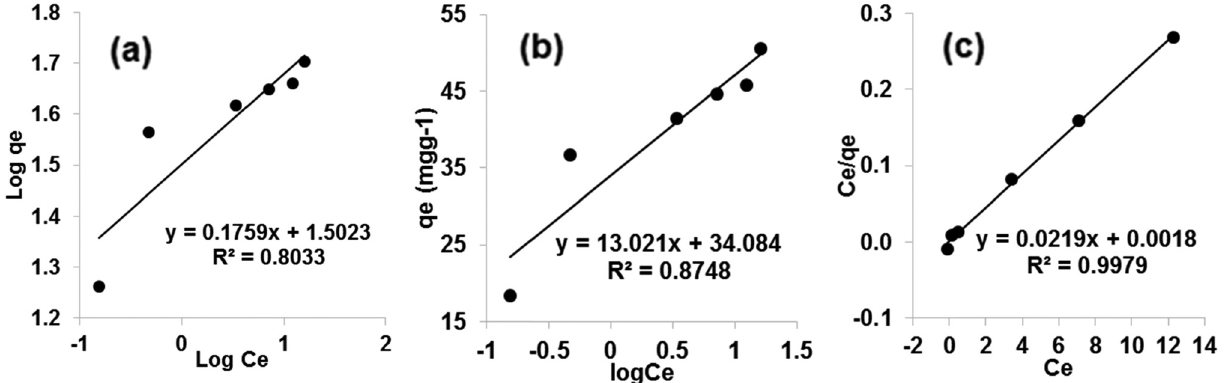
Figure 6: Isotherm models for MO adsorption on CH - g - POEA: ( a ) Freundlich, ( b ) Temkin, and ( c )